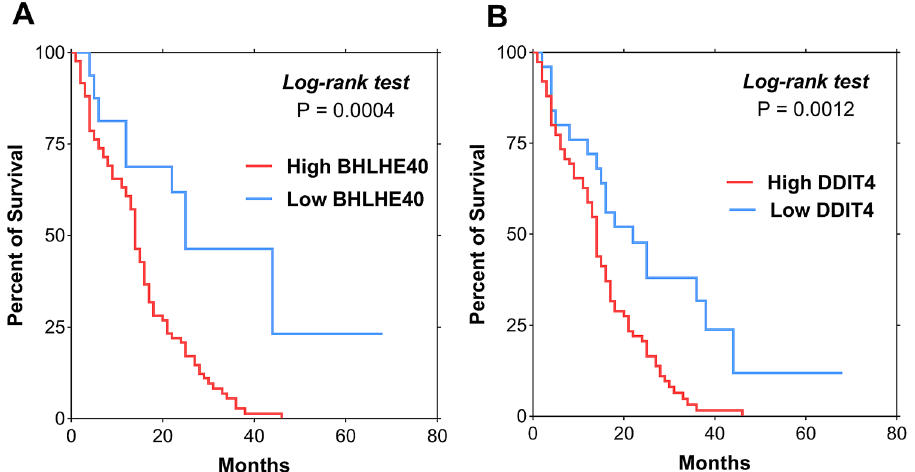
Figure 6. Kaplan–Meier survival curves for overall survival analysis of patients with HBV-HCC ( A ) BHLHE40 ( B ) DDIT4.